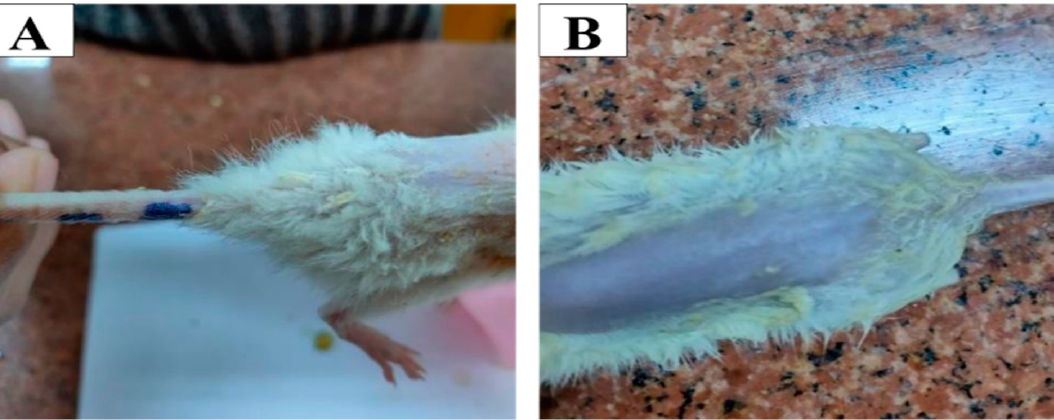
Figure 7. Images showing the rat skin treated with ( A ) the optimized oleogel formulation and ( B ) the lavender oil.